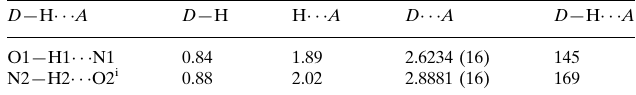
Hydrogen-bond geometry (A˚ , (cid:1)